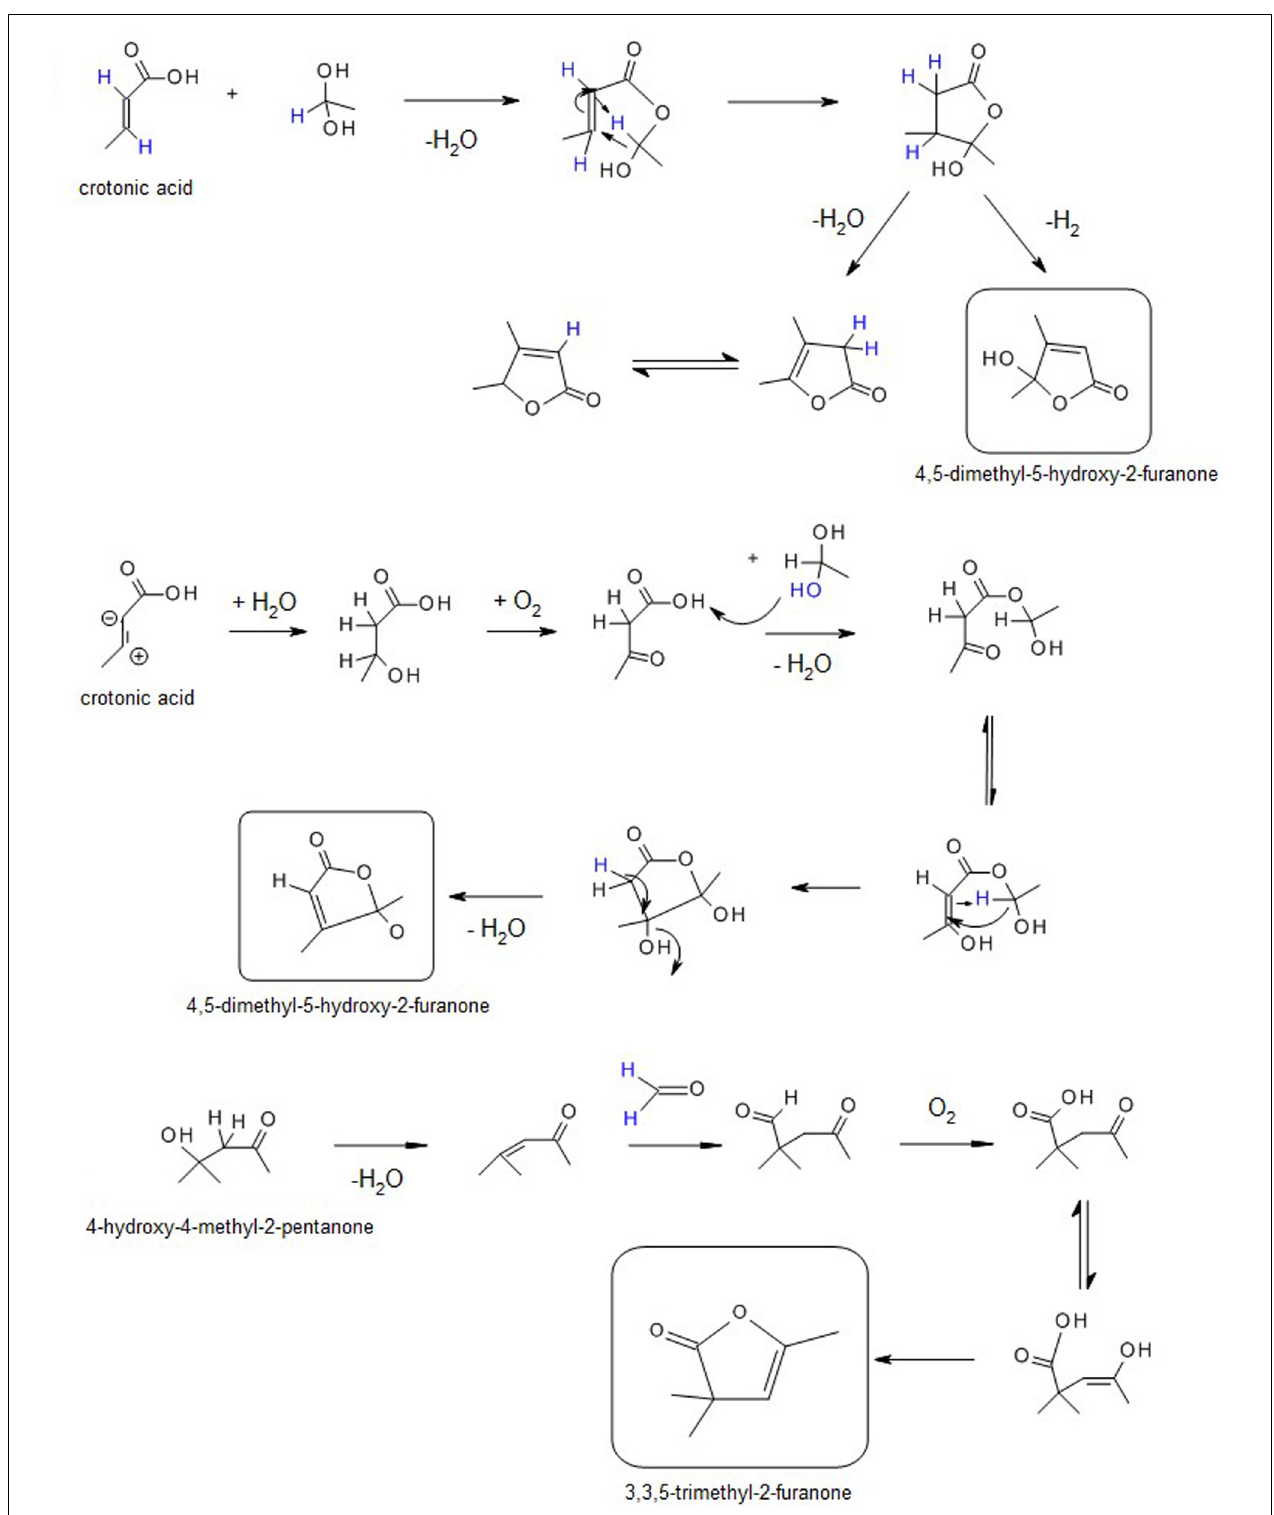
FIGURE 5 | Proposed reaction pathways of furan derivatives.